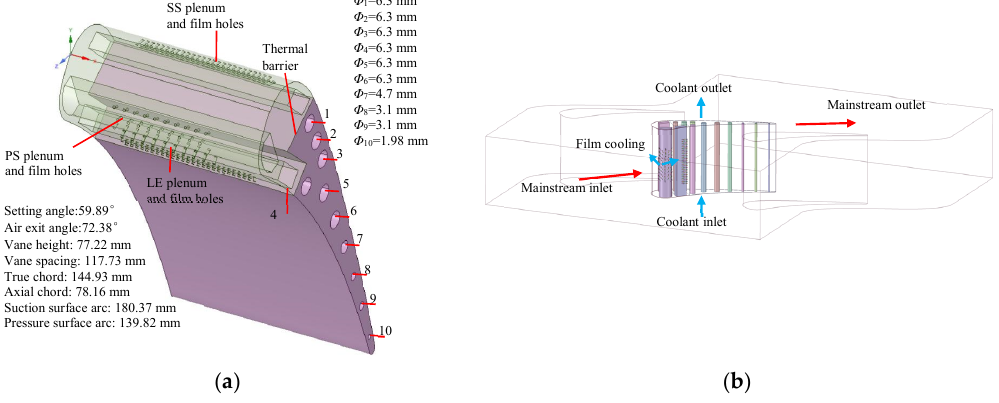
Figure 2. Vane structure and computational domain. ( a ) vane structure, ( b ) computational domain.